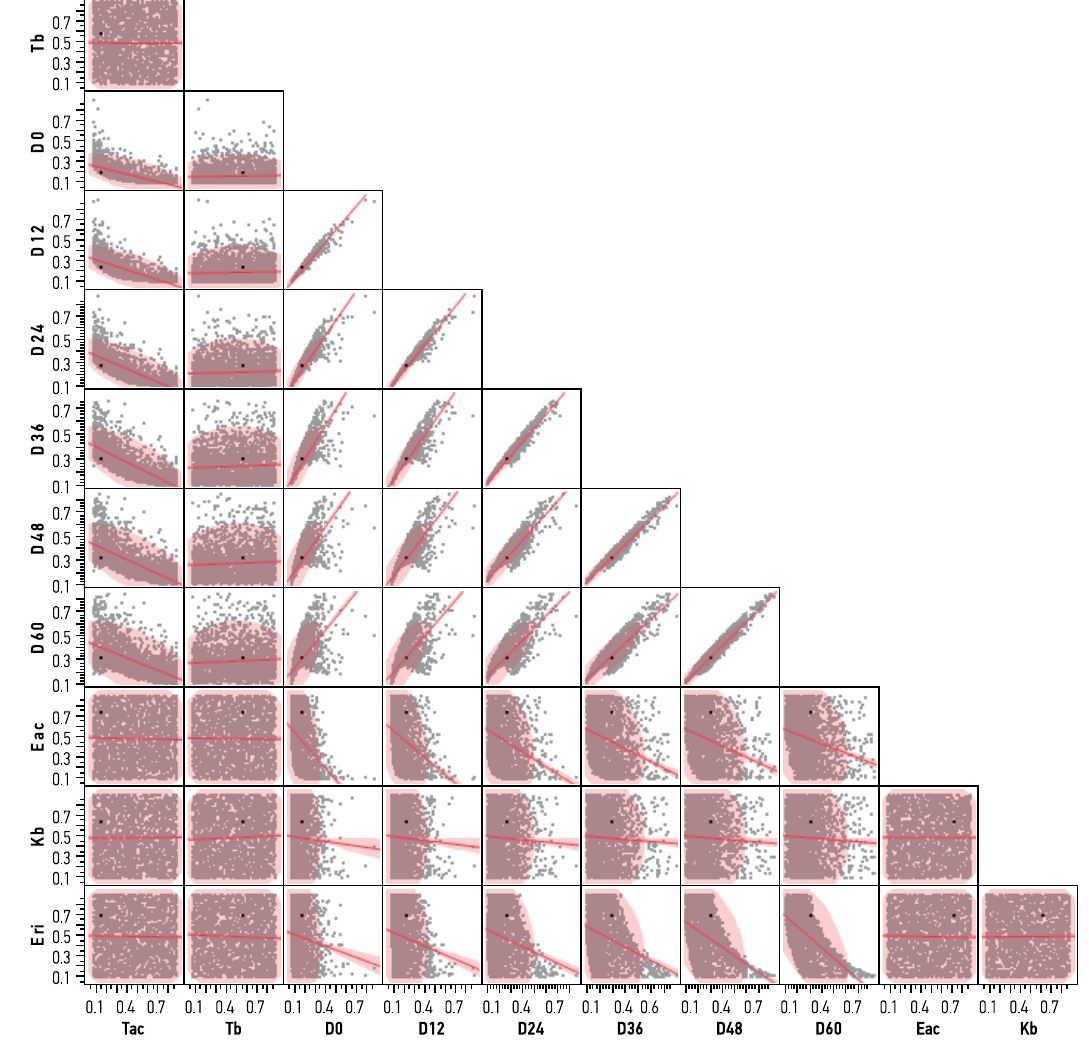
Fig. 3. Scatterplot matrix of input and output variables in the theoretic